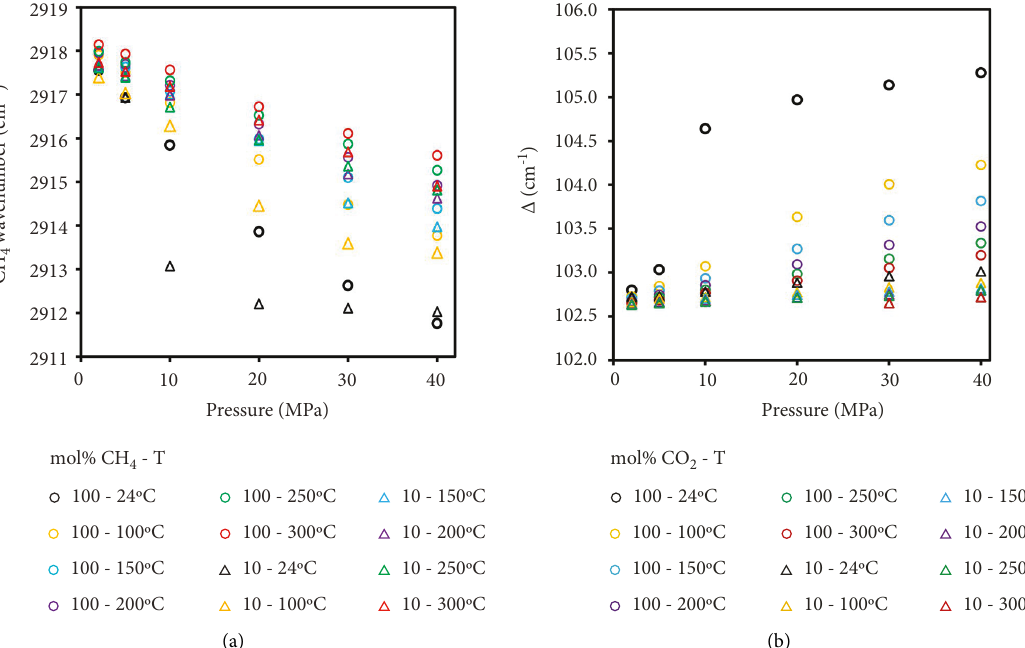
Figure 9: Effect of temperature on the Raman peak positions of (a) the υ ) for pure CO 2 and 10 mol% CH 4 as a function of splitting of CO 2 ( Δ